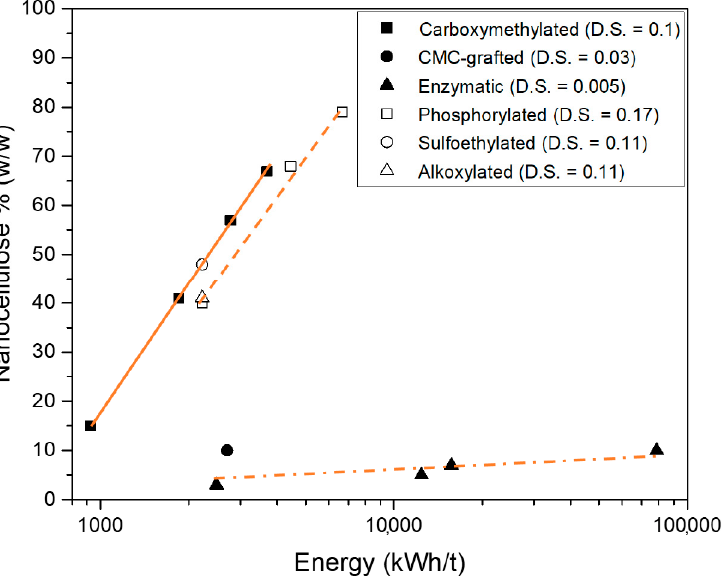
Figure 3. The evolution of the nanocellulose content in various types of CNF-materials (references are given in Table 2).